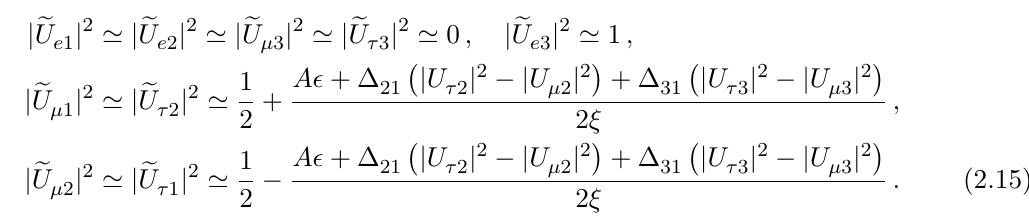
(cid:1) and (cid:1) evolve with the matter e(cid:11)ect parameter A in the cases with 21 31 j j e e